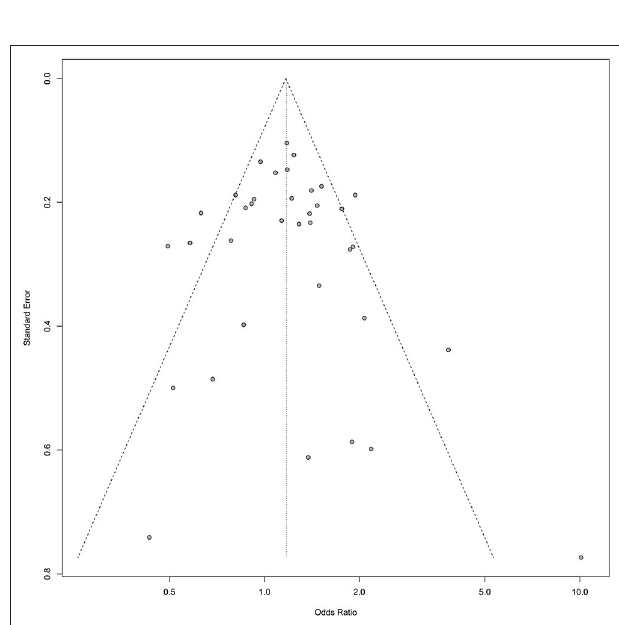
FIGURE 8 | Funnel plot of the association between the AURKA rs2273535 T > A polymorphism and overall cancer risk under the homozygous model (AA vs.